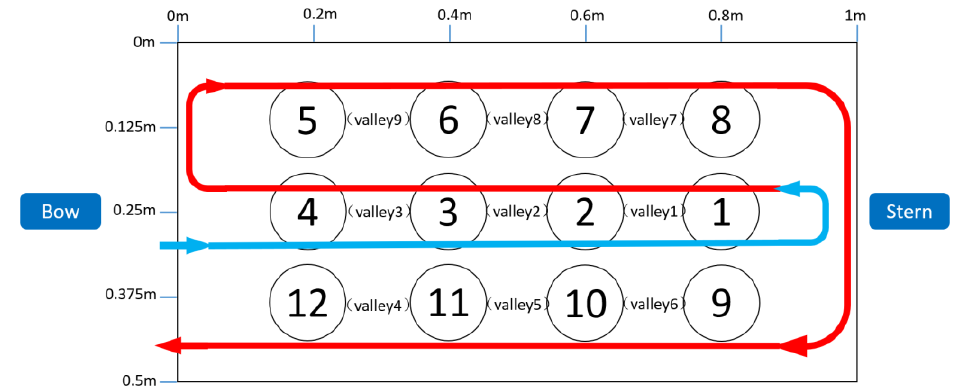
Figure 9. Schematic diagram of stack position for bulk solids stacking experiment.